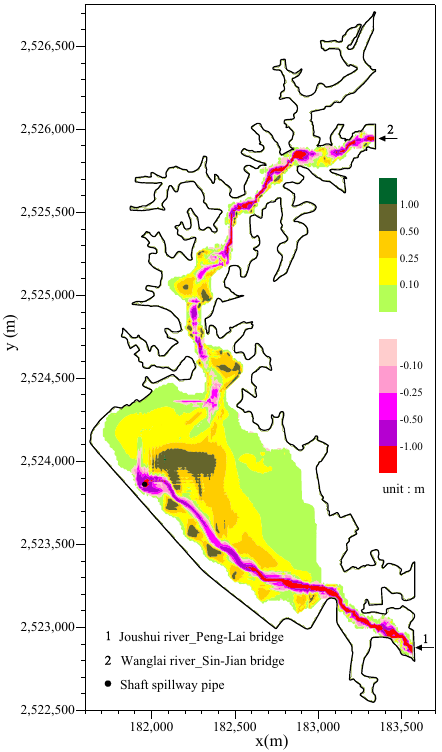
Figure 8. Bed evolution in the reservoir during a five-year return period, t = 120 h.